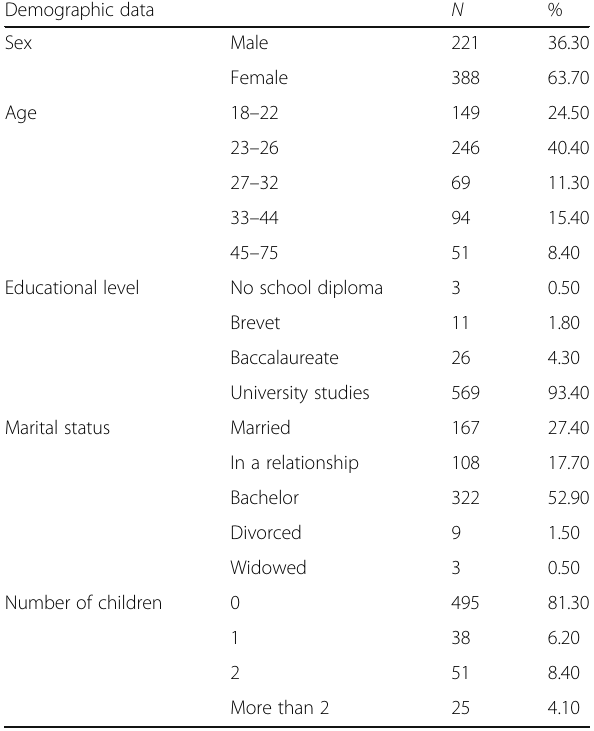
Table 1 Sociodemographic data of the respondents ( N =